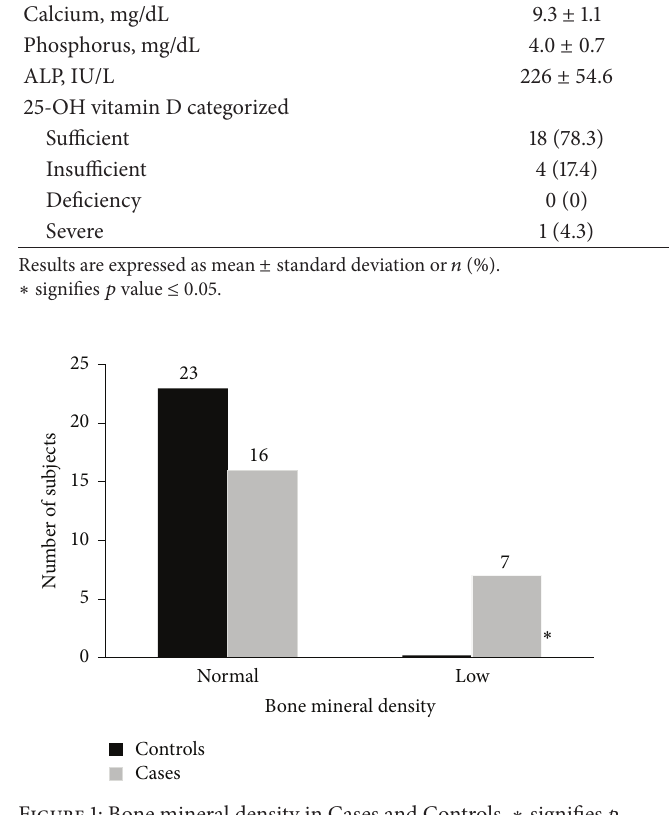
Figure 1: Bone mineral density in Cases and Controls. ∗ signifies p value ≤ 0.05.